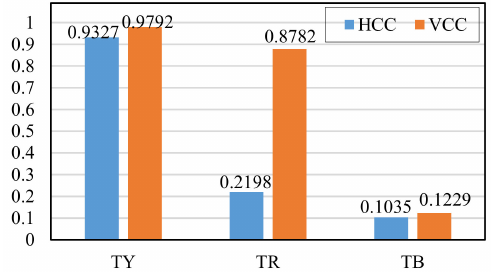
Figure 19. Correlation coe ffi cients of the three candidate images.